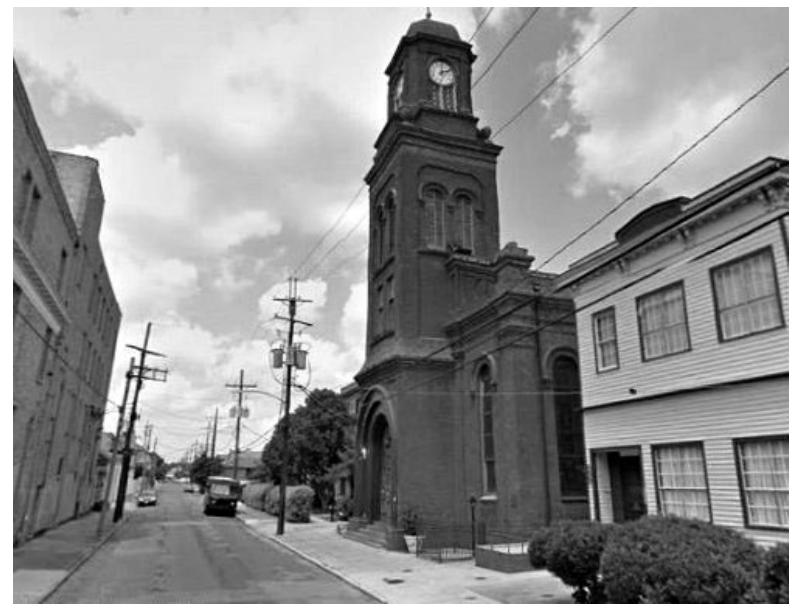
Figure 8. Saint Vincent de Paul Catholic Church, New Orleans, Louisiana; image from the website http://old-new-orleans.com/NO_Three_Churches.html (accessed on 28 June 2018); photo credit to Three Historic Churches. June 2017.